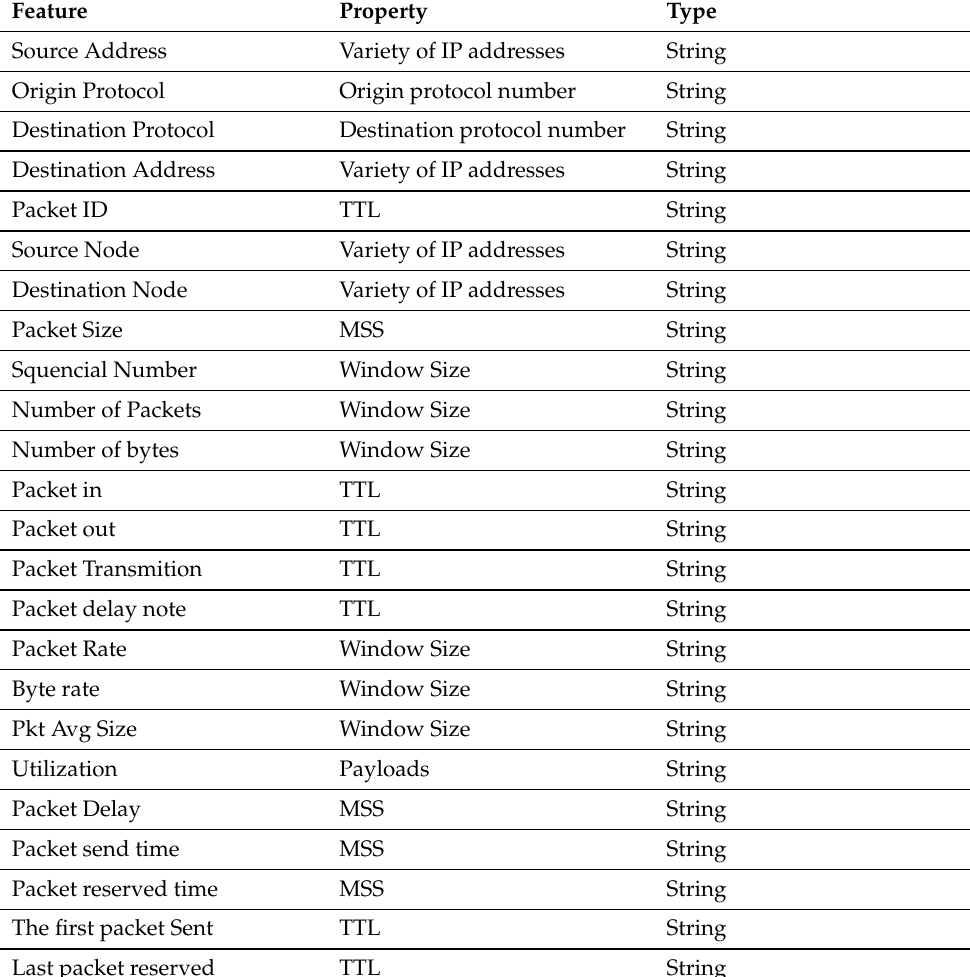
Table 4. Properties considered to generate a set of appropriate network